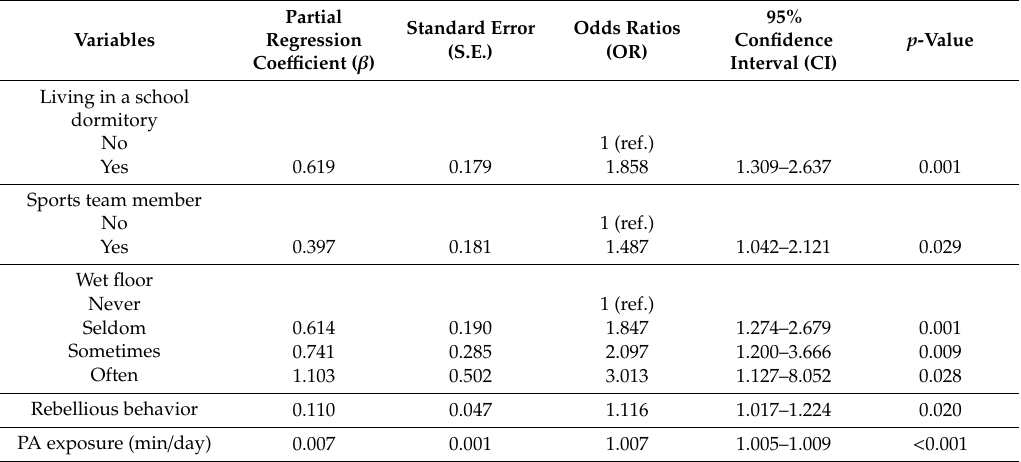
Table 4. Multivariate logistic regression to estimate risks factors for physical activity-related injuries (PARI) among boys.